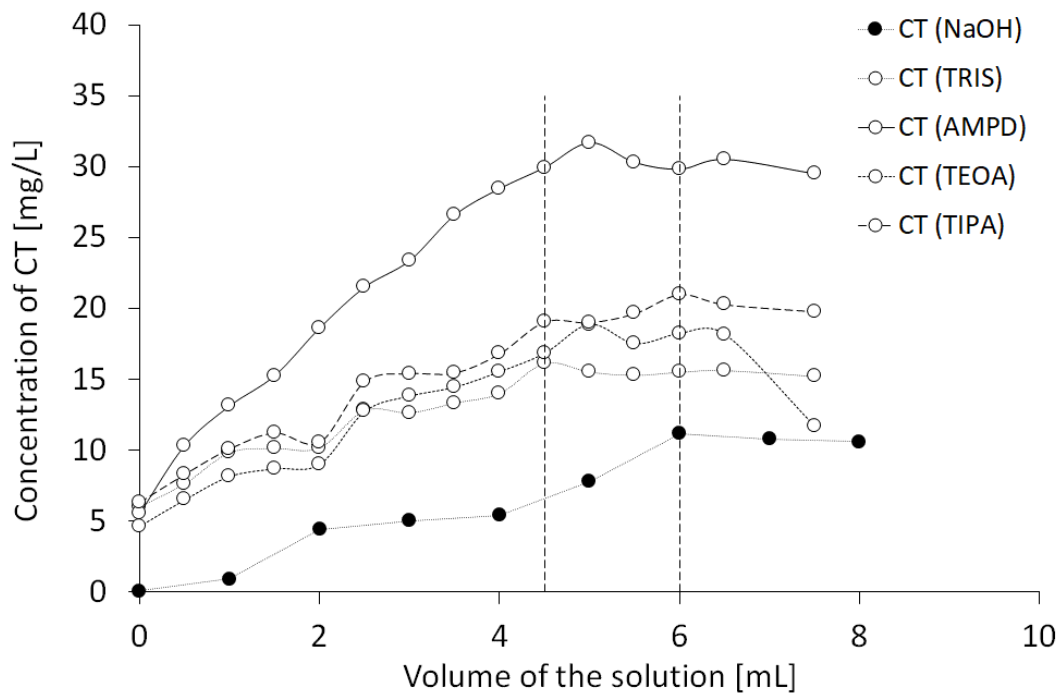
Figure 4. Influence of solutions (0.001 mol/L NaOH, 1% AMPD, 1% TRIS, 1% TEOA, and 1% TIPA (n = 3)) on the spectrophotometrically estimated neutralization of CT by the alkaline components.